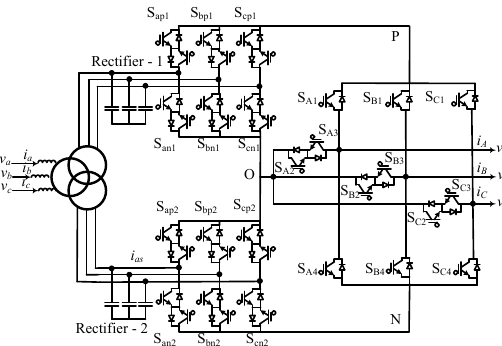
Figure 3. The Three-level T-Type Indirect Matrix Converter Topology.